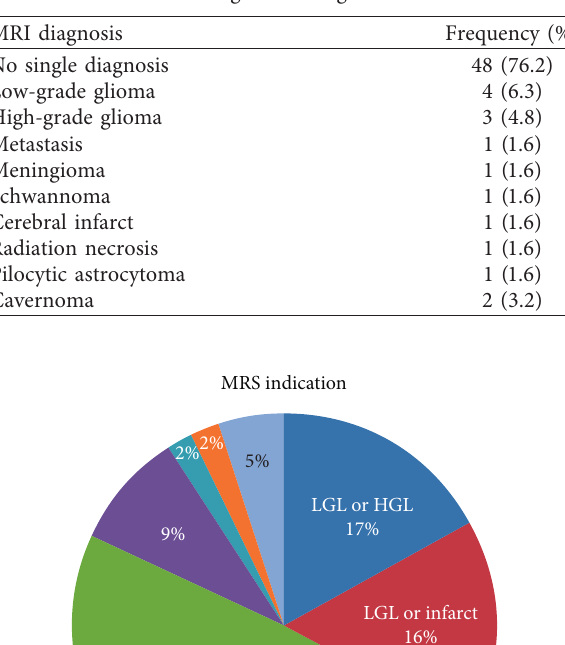
Table 1: Diagnoses using MRI alone.